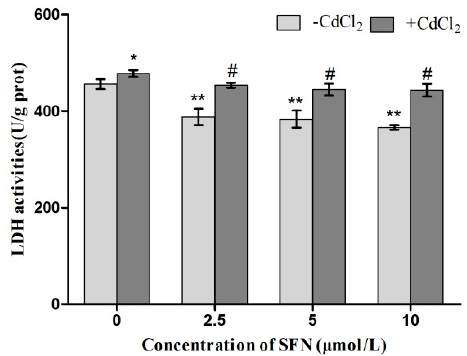
Figure 4. Activity of LDH in TM3 cells. * and ** represent a significant and extremely significant difference, respectively, compared with the control group. # represents a significant difference, compared with the Cd group.